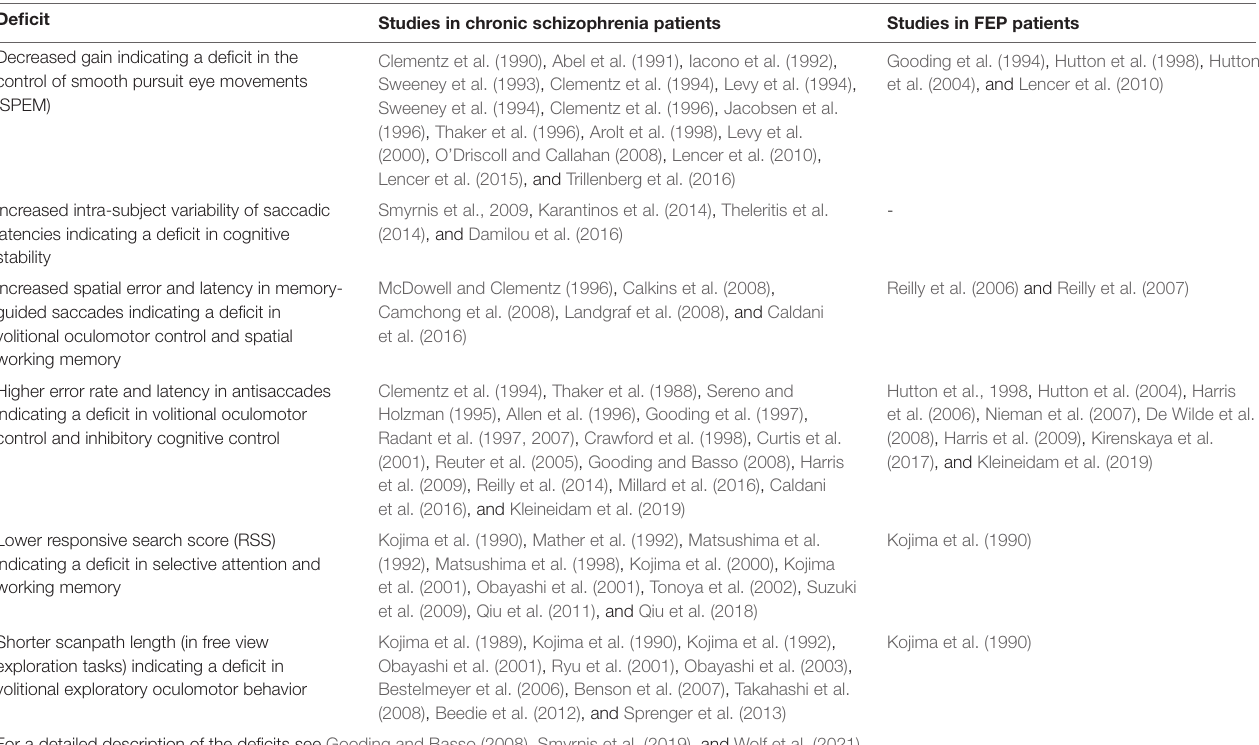
TABLE 2 | Summary of deficits found in chronic schizophrenia and FEP patients. Deficit Studies in chronic schizophrenia patients Studies in FEP